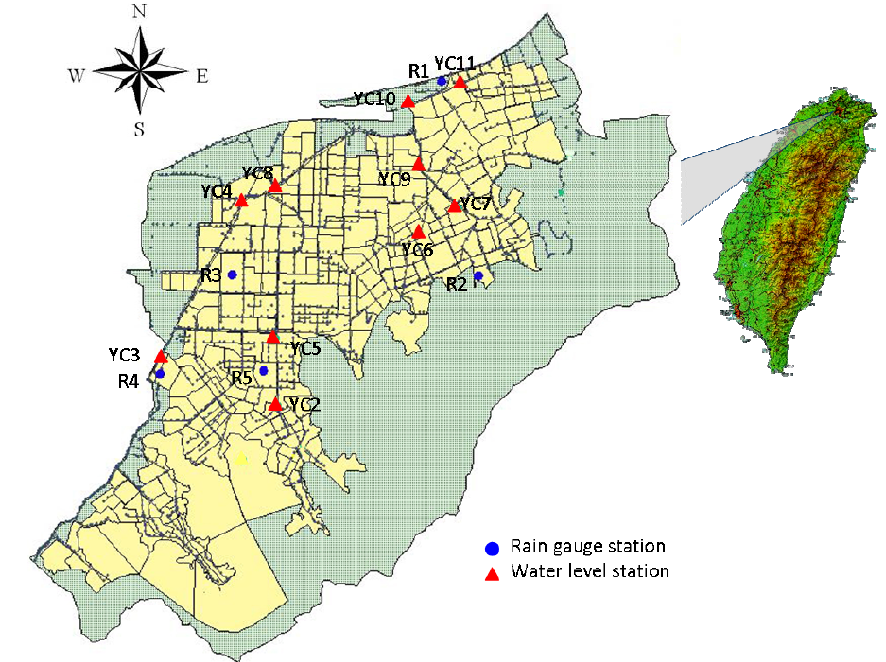
643 Fig. 2. The locations of Yu-Cheng catchment and the monitoring stations. Figure 2 The locations of Yu-Cheng catchment and the monitoring stations 644 645 Table 1. Data from storm events for water level predictions. Config.